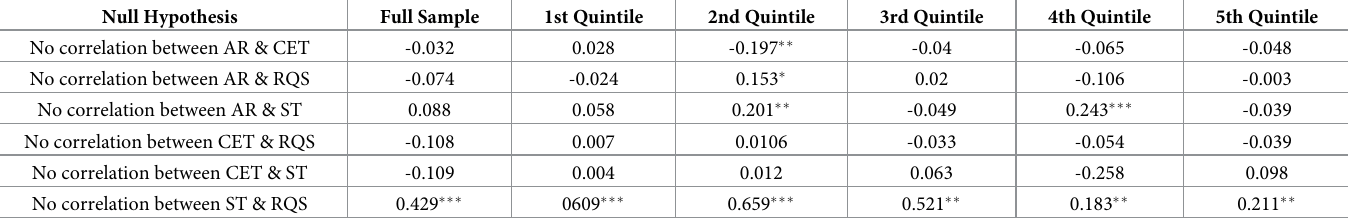
Table 4. Correlation analysis between liquidity measures for the full sample and quintile